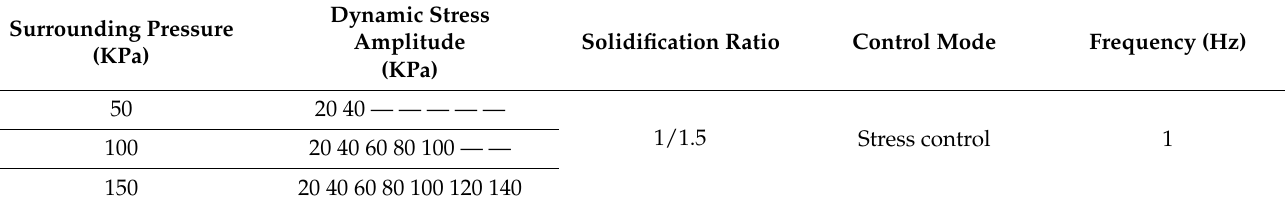
Table 3. Dynamic triaxial test